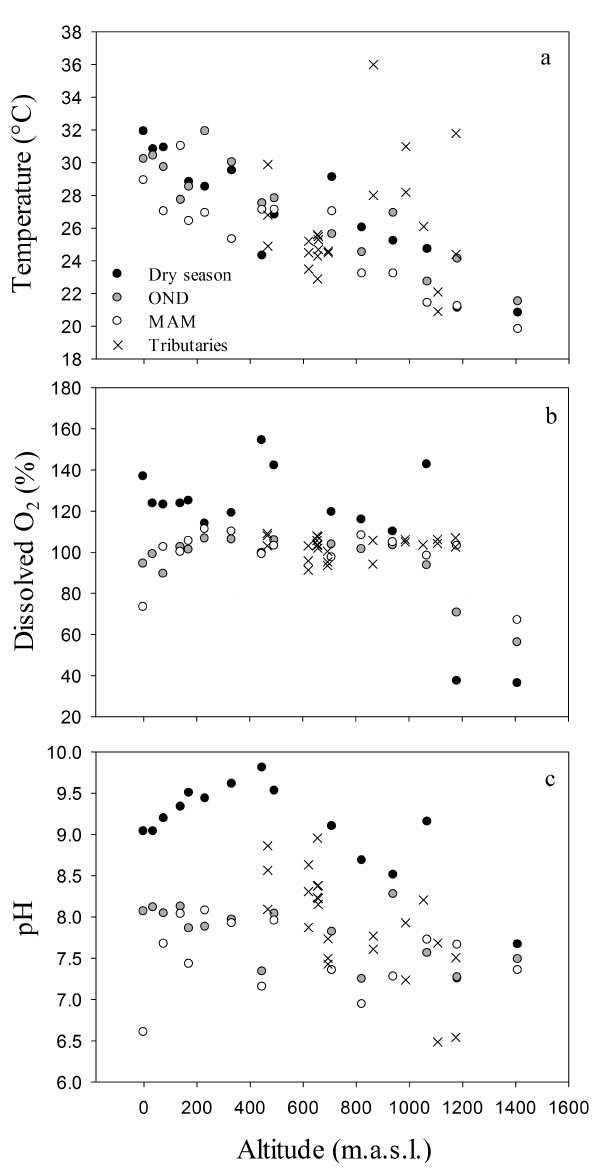
Fig. 3. Altitudinal gradient during dry season (August–September 2011), short rain season (October–December, OND, November 2011) and long rain season (March–May, MAM, April 2012) and tributaries (x, all seasons) of in-stream (a) temperature ( ◦ C), (b) dissolved oxygen (%), and (c) pH.